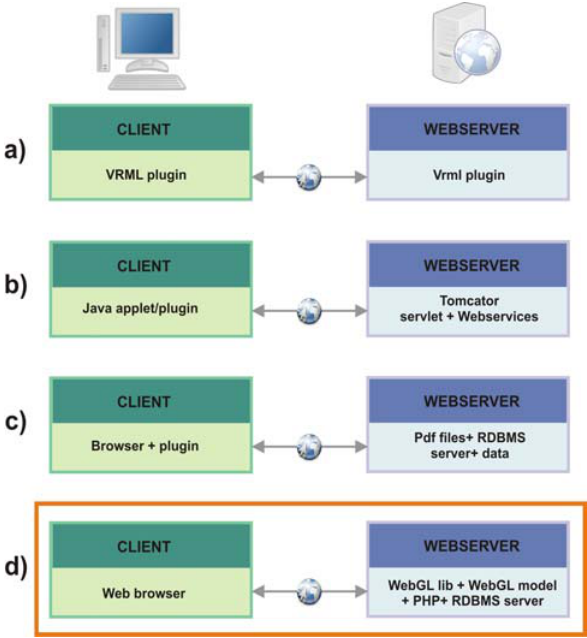
Figure 1. Different options to share and browse on Web 3D geospatial models (highlighted in orange the proposed